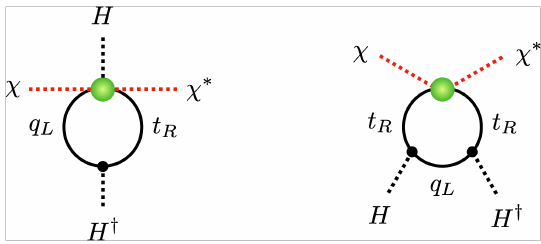
Figure 3 . Left: an example of a diagram that describes the mixing of the Yukawa-type DM-top operator into the marginal Higgs portal operator. Right: example graph that could lead to a mixing of the current-current type DM-top operator into the DM-Higgs operators in (2.1). See text for further